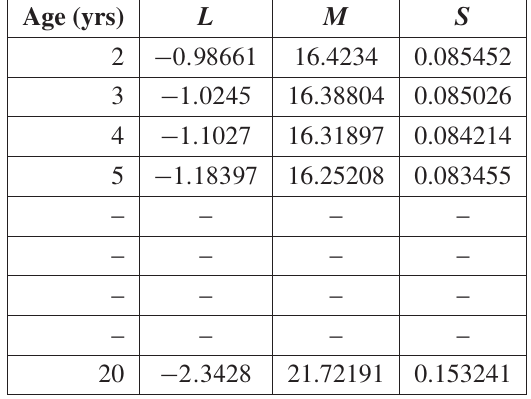
Table 2. L , M , S parameters for